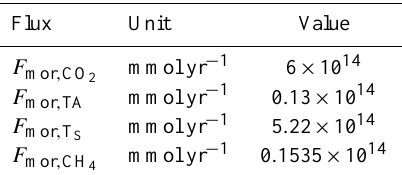
Table 6. Hydrothermal fluxes as given by Elderfield and Schultz